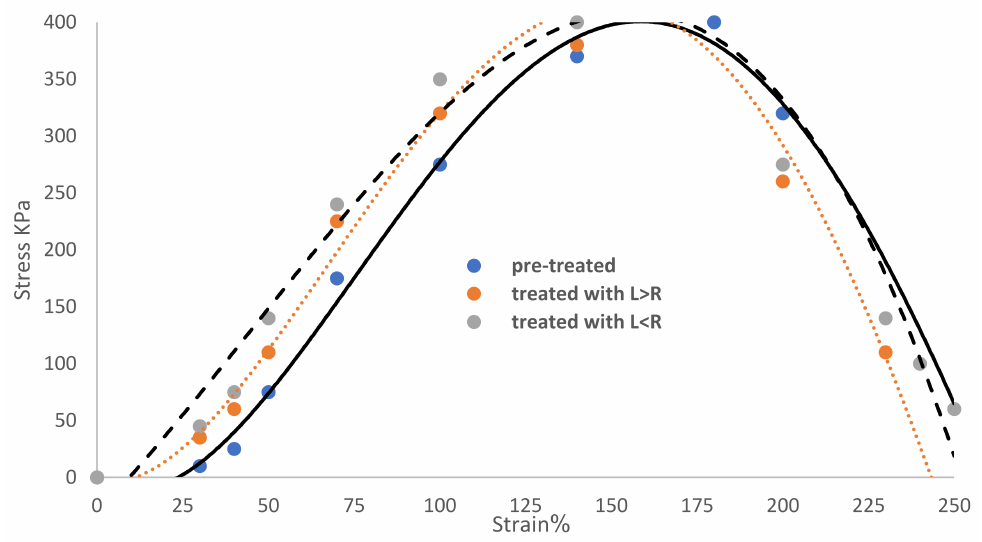
Figure 3. The measured mechanical properties of the pre-treated samples and treated samples with L < R and L >